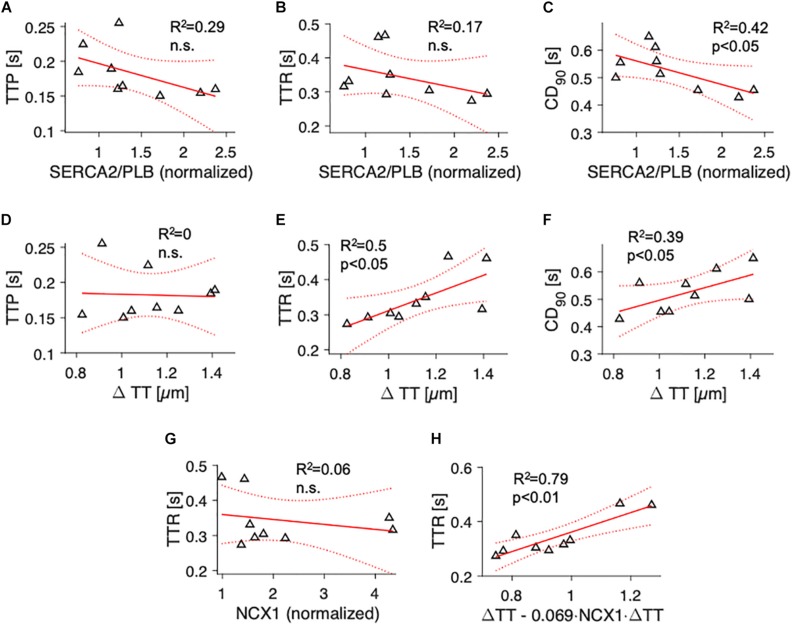
Association of contraction parameters at 1 Hz pacing rate with SERCA2/PLB ratio, t-tubule distance and NCX1 expression. Linear models showing the correlation of (A) time to peak (TTP), (B) time to relaxation (TTR), and (C) 90% contraction duration (CD90) with SERCA2/PLB, and of (D) TTP, (E) TTR and (F) CD90 with t-tubule distance (ΔTT). R2 is the coefficient of determination, p indicates the probability of type I error of linear regression. Dotted lines indicate 95% confidence intervals. (G) Correlation of TTR with NCX1. (H) Multivariate regression model combining ΔTT and the interaction of ΔTT with NCX (ΔTT + ΔTT:NCX) as predictors of TTR. The fitted model, TTR = 0.36⋅(ΔTT – 0.069⋅ < cps:it > NCX1 < /cps:it > ⋅ΔTT), explains the variance in TTR significantly better than simple linear models with only NCX1 (p < 0.001) or ΔTT (p = 0.01, likelihood ratio test).